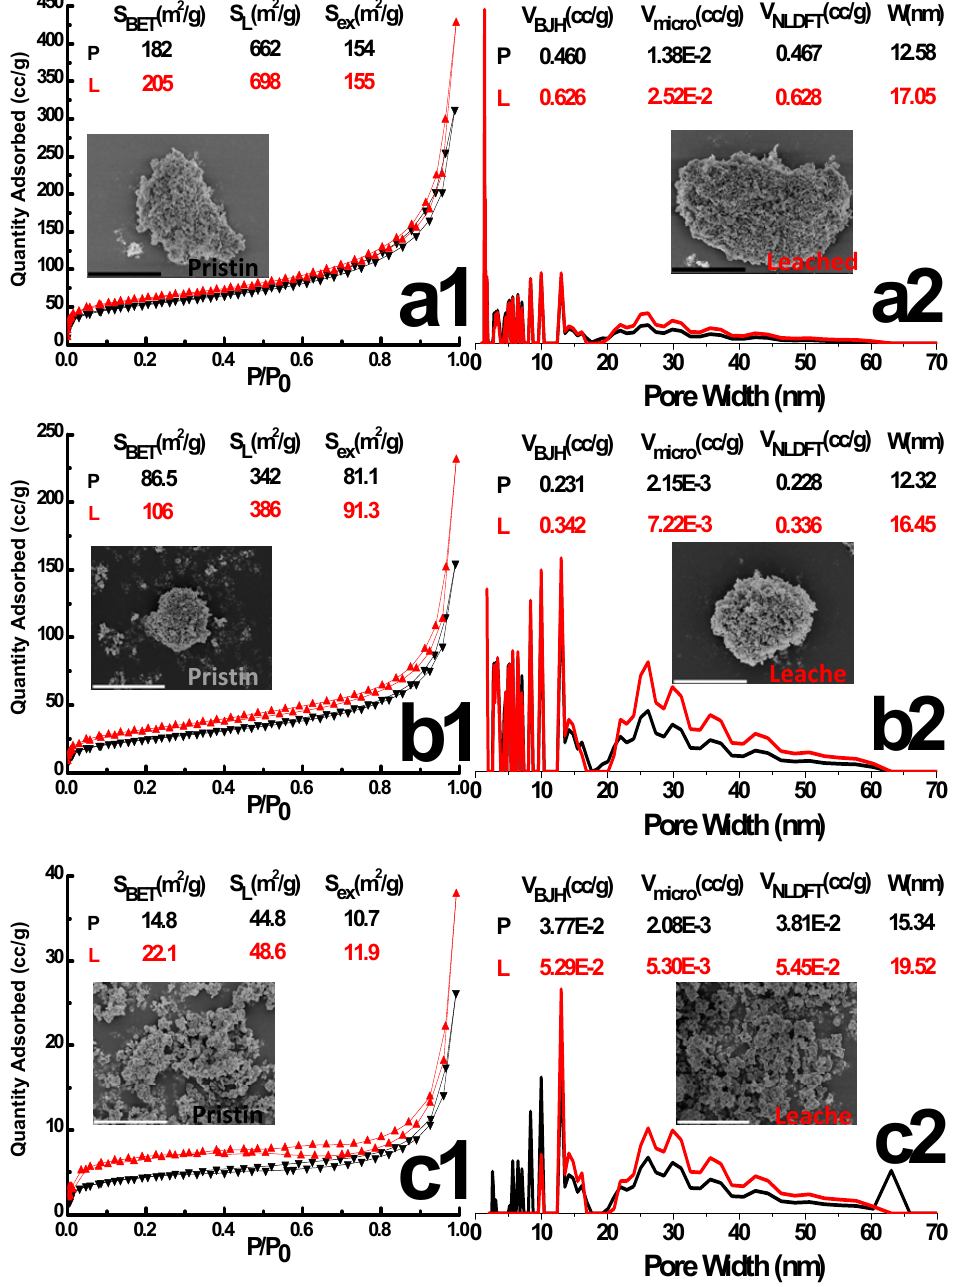
Figure 3. The N 2 adsorption ‐ desorption isotherm and Pore Size Distribution (PSD) of pristine (P) and leached (L) tin alkylphosphonates by NLDFT: ( a ) Sn ‐ ATMP; ( b ) Sn ‐ EDTMP; ( c ) Sn ‐ DTPMP. The surface area, pore width, pore volume and particle morphology are depicted as inset. The scale bar of SEM image is 5 µ m. The S BET , S L , S ex , V BJH , V micro , V NLDFT and W in the figure represents BET surface area, Langmuir surface area, external surface area, BJH mesopore volume, BJH micropore volume, NLDFT micropore volume and BJH pore